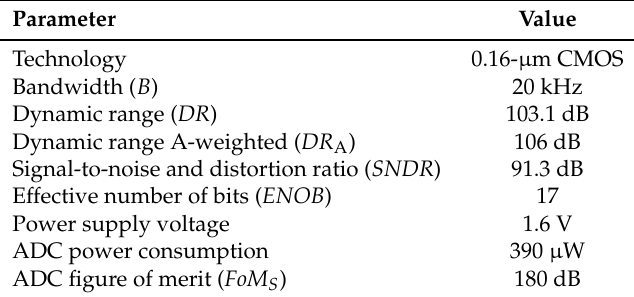
Table 6. Measured performance summary (example